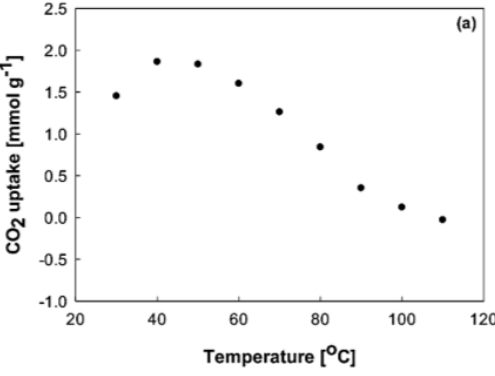
Figure 7. The effect of temperature on the adsorption capacity of 2.0PO-PEHA/MPS. Reproduced with permission from [80] .